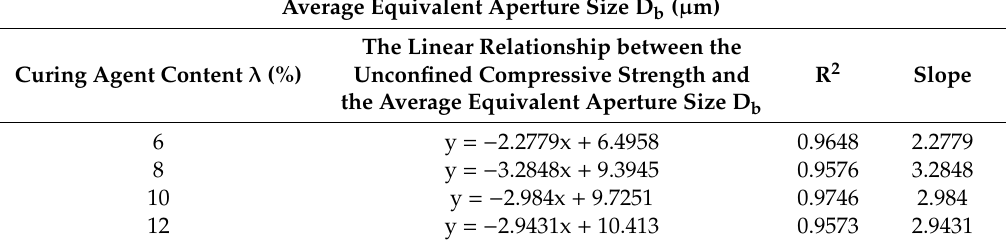
Table 11. Linear relationship between the unconfined compressive strength and the average equivalent aperture size.